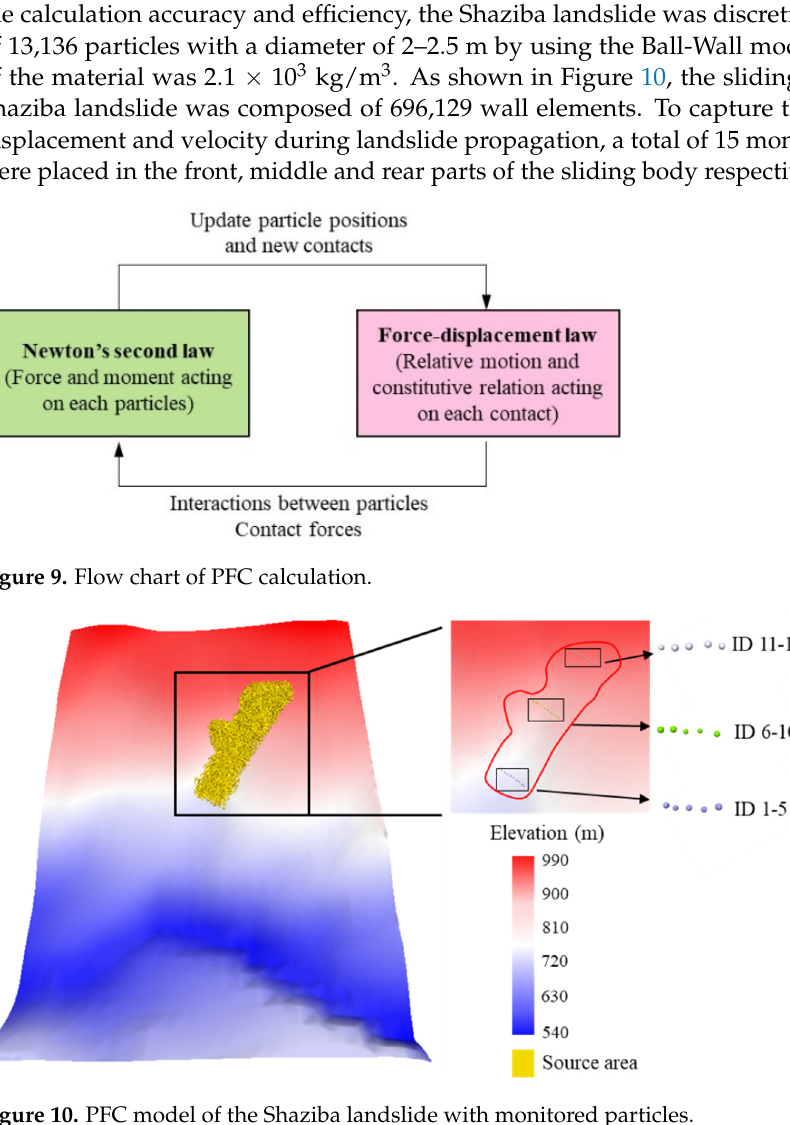
Figure 9. Flow chart of PFC calculation.